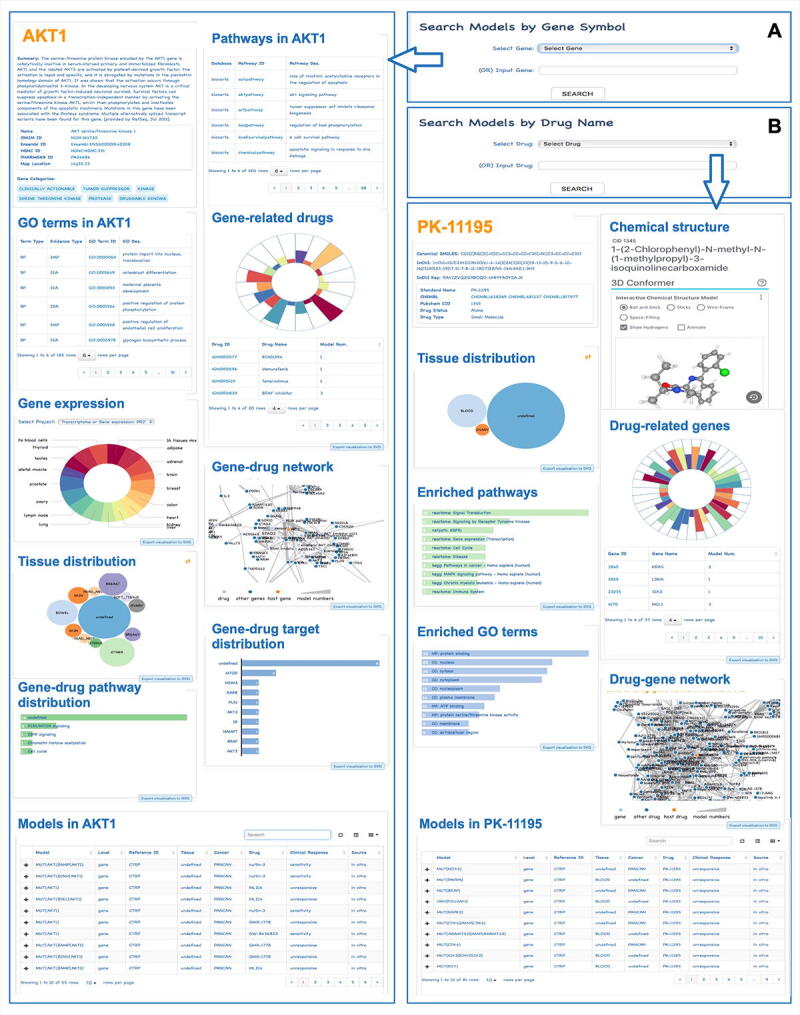
Searching models in iGMDR. A. Model and profile searching by inputting a gene symbol. B. Model and profile searching by inputting a drug name.